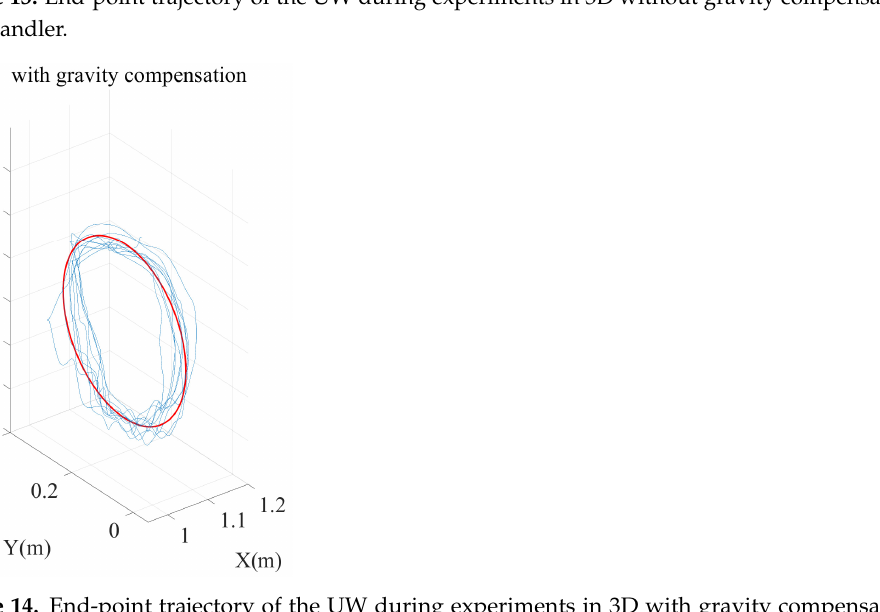
Figure 14. End-point trajectory of the UW during experiments in 3D with gravity compensation of K-handler.